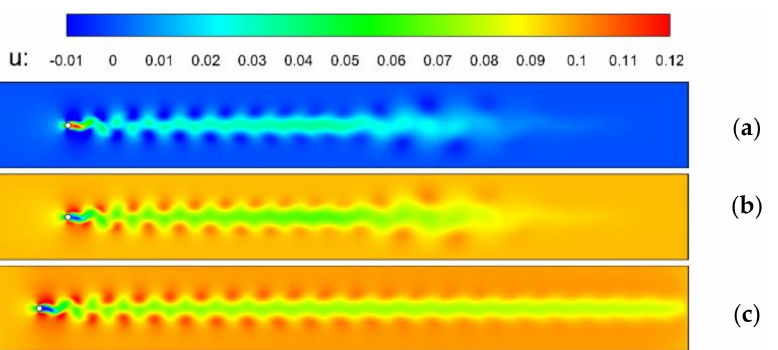
Figure 5. Transverse velocity flow field: ( a ) moving cylinder; ( b ) moving cylinder after transforma- tion; ( c ) static cylinder.